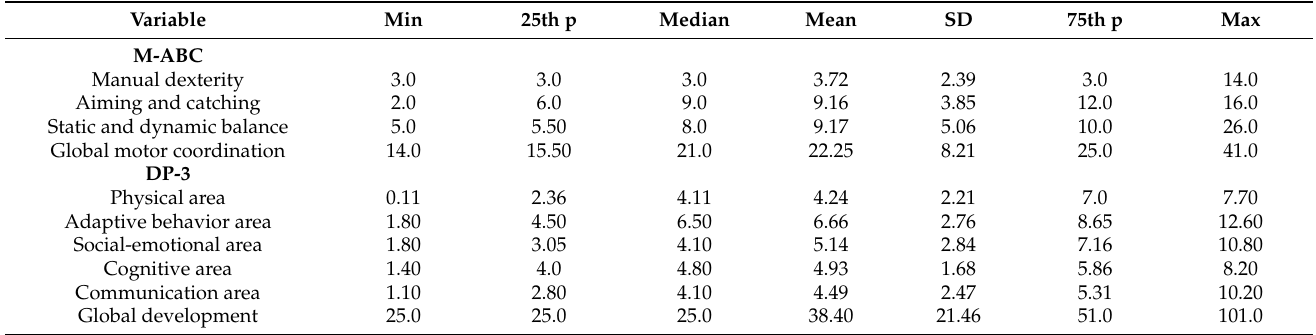
Table 1. Descriptive statistics of the entire